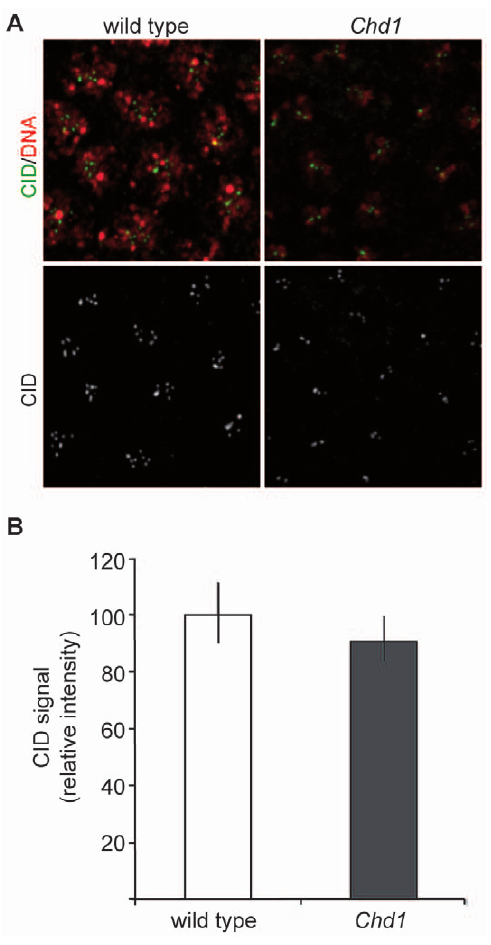
Figure 5. CenH3 CID loading is not compromised in Chd1 null embryos. A) Embryos from wild-type and Chd1 null flies were stained with anti-CenH3 CID antibodies (green). DNA was visualized with DAPI (red). B) Quantification of signal intensities of CenH3 CID foci in wild-type and Chd1 null embryos (5 embryos each) as described in Material and Methods. CenH3 CID signals have similar intensities indicating that CHD1 has no impact on CenH3 CID loading.